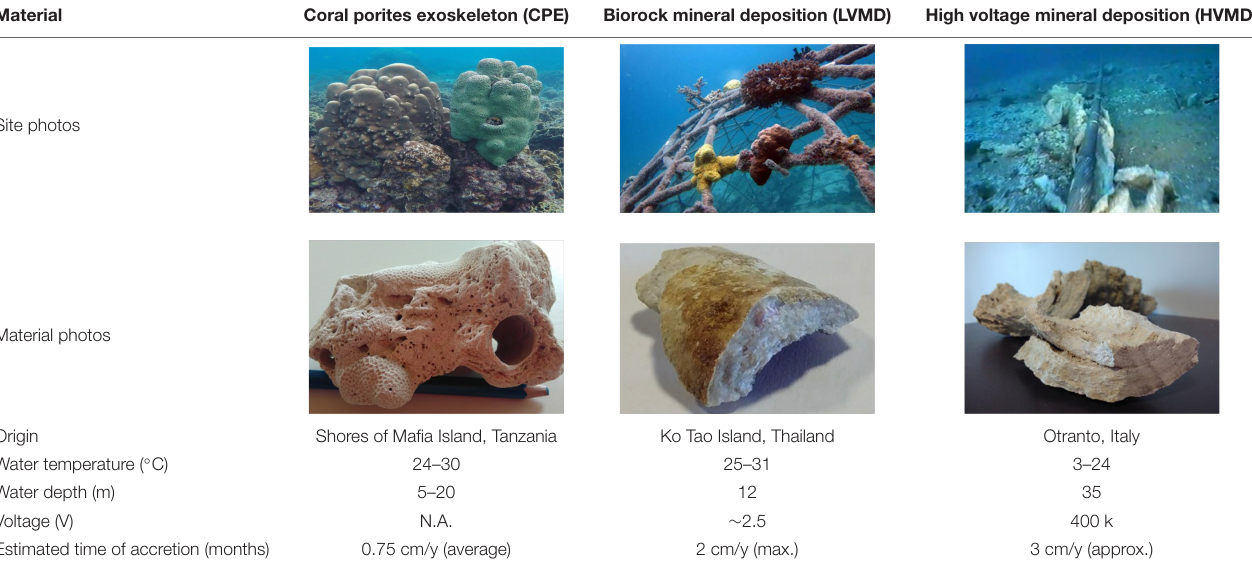
TABLE 1 | The investigated calcium babonates and their origin. For HVMD, Underwater Photo—by S.T.E.S. (Sub Techinal Edil Service).